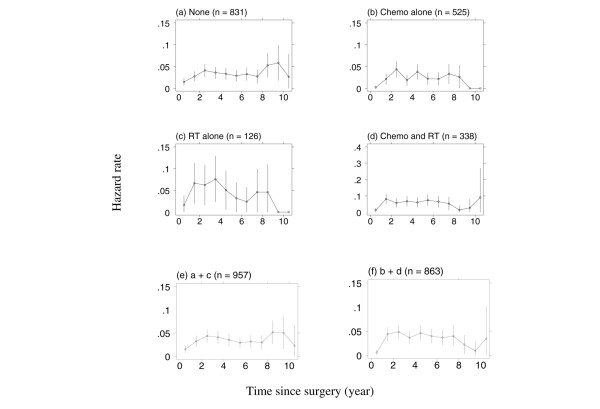
Hazard rates for death in ethnically Chinese breast cancer patients. (a) Mastectomy alone. (b) Adjuvant chemotherapy without radiotherapy. (c) Radiotherapy without chemotherapy. (d) Both modalities. (e) Local therapy only. (f) Systemic therapy. Note the different scale used for the hazard in panel d. Chemo, chemotherapy; RT, radiotherapy.